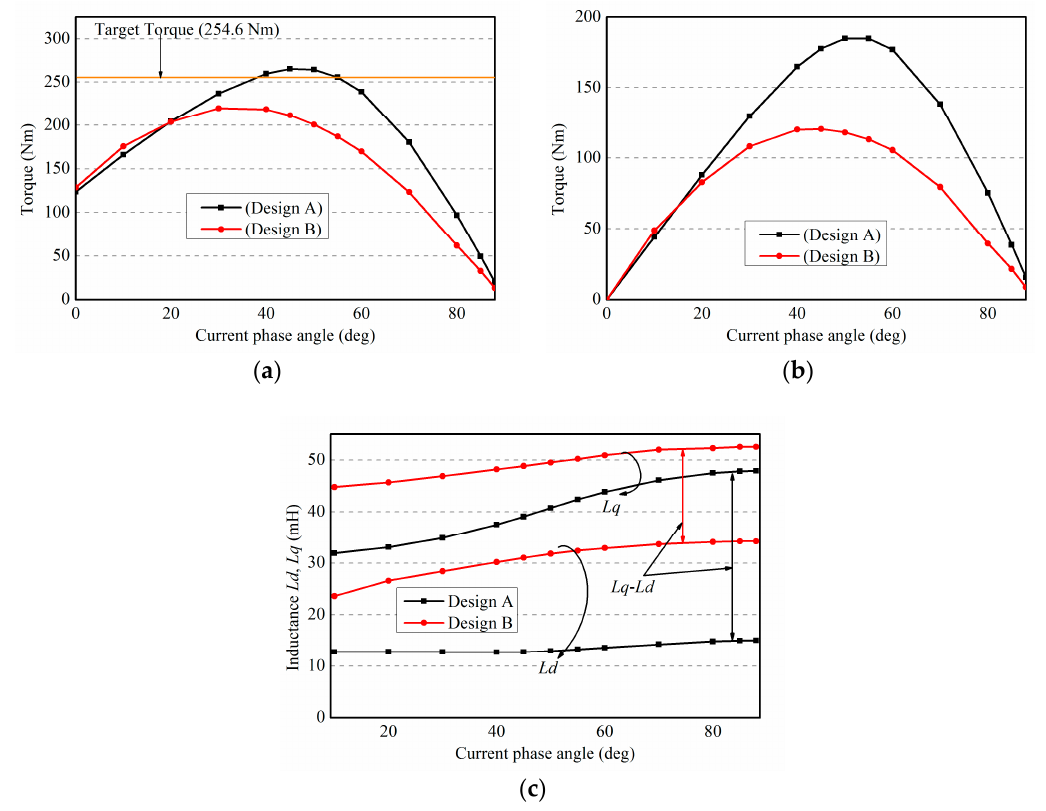
Figure 12. Torque and inductance under different current phase angles with a current magnitude of 30 A: ( a ) Total torque; ( b ) Reluctance torque; ( c ) Inductances.